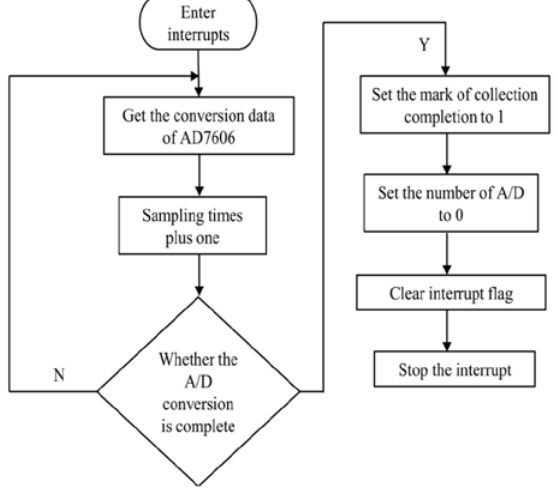
Fig. 4. Main program flow chart.